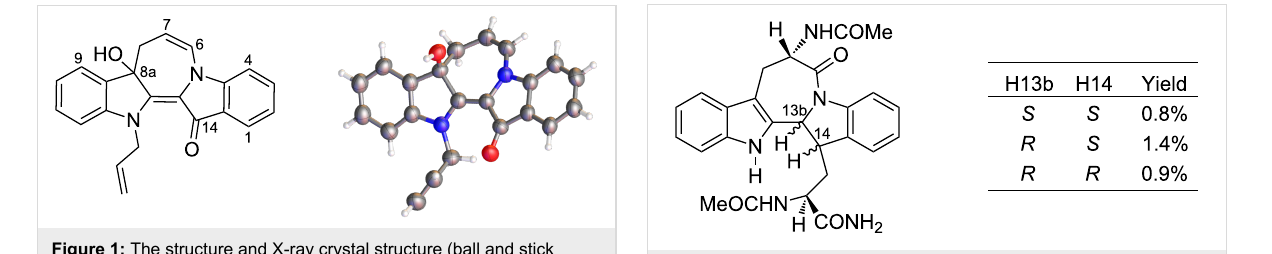
Figure 2: Dihydroazepino[1,2- a :3,4- b ']diindolones from N b -acyl-L-tryp- tophanamides